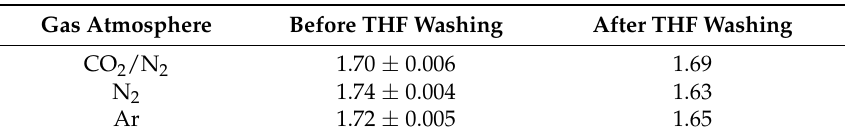
Table 4. Thermal swelling ratio of